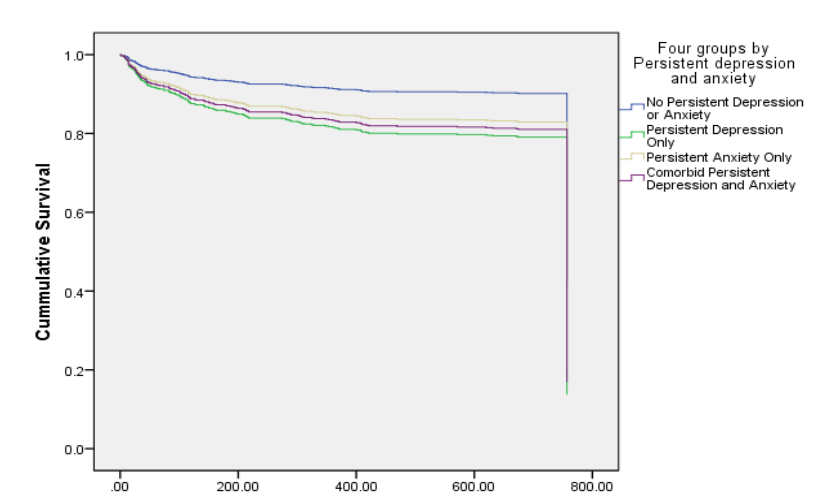
Figure 1. Ac ute coronary syndrome second event according to comorbid depression and anxiety. Figure 1. Acute coronary syndrome second event according to comorbid depression and